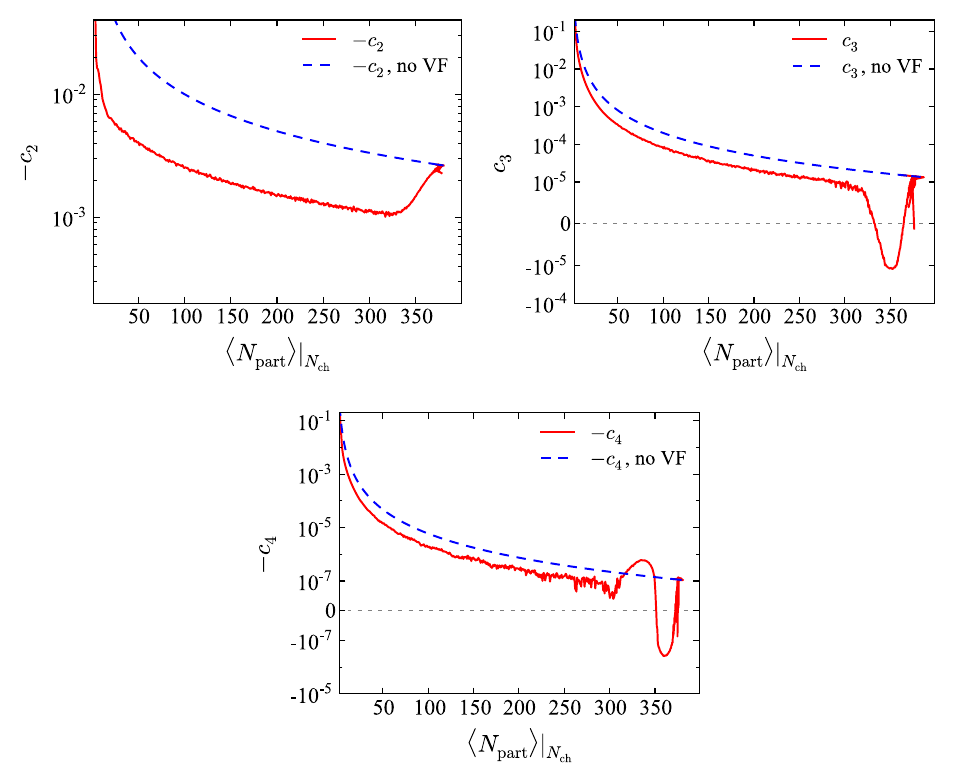
√ Fig. 1 The couplings − c 2 , c 3 , − c 4 for s = 7 . 7 GeV in Au+Au collisions as a function of (cid:6) N part (cid:7)| N The ( blue ) dashed curves represent the results without fluctuations of the number of wounded nucleons (“no VF”), see Eq.